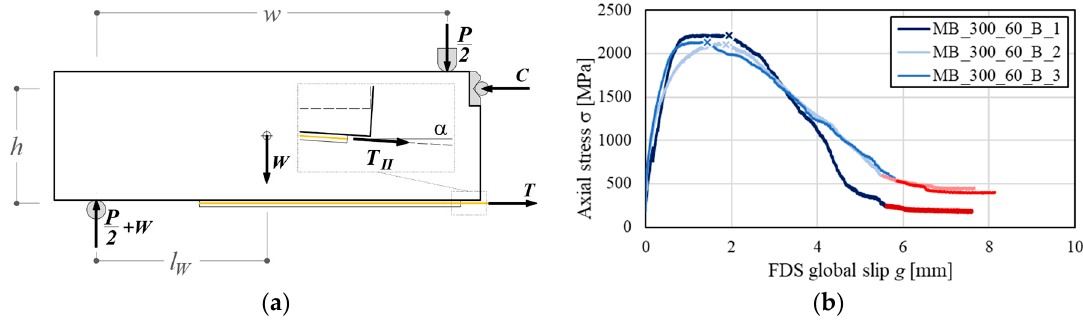
Figure 4. Modified beam tests: ( a ) free body diagram; ( b ) σ - g responses at fully debonded side (FDS) of quasi-static monotonic tests (the peak stresses σ * are indicated with a “x” marker whereas the curve portions characterized by first derivative values within the range ( − 200,0) are depicted in red). Table 3. Results of quasi-static monotonic modified beam tests.